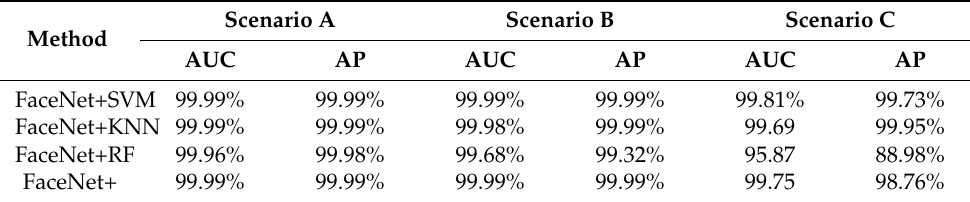
Table 10. AUC and AP comparison in different scenarios of our proposed methods.